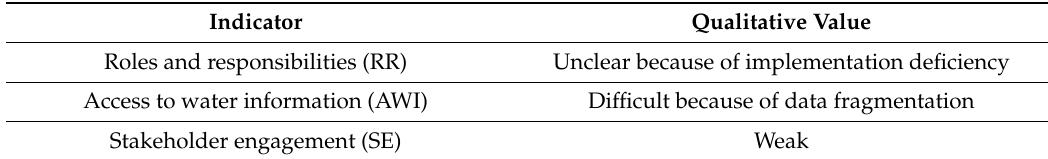
Table 21. Water governance indicators.